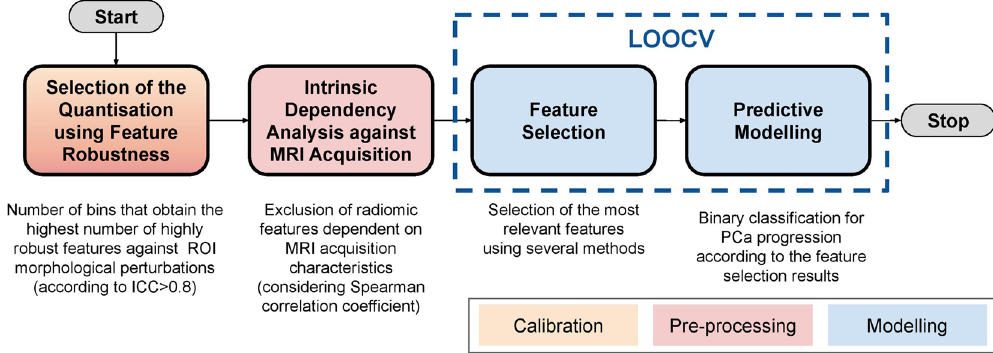
Figure 2. Overall workflow of the radiomics pipeline used in this study. The main phases are: (i) calibration, (ii) pre-processing, and (iii) predictive modelling with leave-one-out cross validation (LOOCV), for which a colour legend is shown in the bottom right